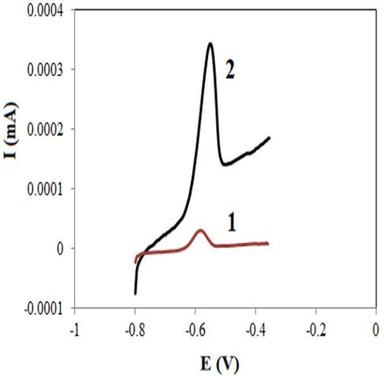
DPASVresponse of the GO-imi- (CH2)2-NH2/CPE and CPE in 200 nM concentrations of Pb(II) in acetate buffer (pH 5.0).